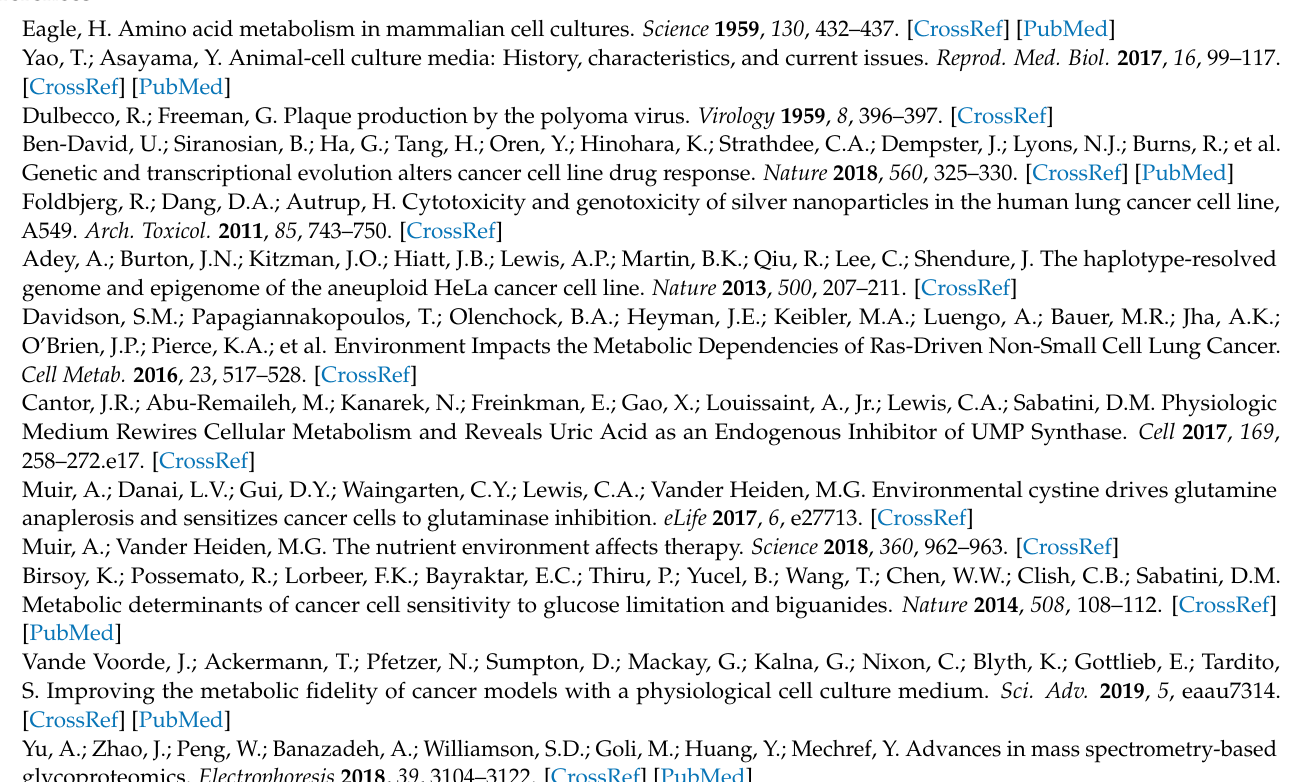
Table S2: Major nutrients and metabolites with different amounts in Plasmax, EMEM and DMEM. The commercial media include high abundance of Glucose, Glutamine, etc., while Plasmax mimics the concentration of human blood, and includes metabolites such as Urea and Urate, Table S3: Relative abundance of glycans from 231BR cell line, Table S4: Relative abundance of glycans from CRL cell line, Table S5: RPKM of glycogenes expressed in 231BR and CRL cell lines cultivated by three media, Figure S1: Nutritional composition of three media: Plasmax, EMEM, and DMEM, Figure S2: Examples of positional structural identification method N -glycans, Figure S3: Heatmaps of significant N -glycans from 231BR cell line and CRL cell line, Figure S4: Heatmaps of significant O -glycans from 231BR cell line and CRL cell line, Figures S5–S7: RPKM of transcript expressions of glycosyltransferases that correlated with changes in glycomes, and glycan synthesis